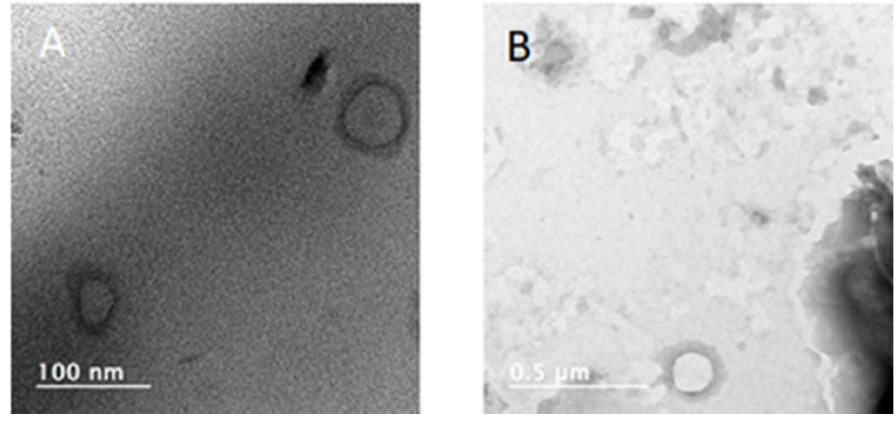
Figure 2. TEM images of ( A ) PdiMeMLABn 30 , and ( B ) PdiMeMLAHe 30 based NPs.